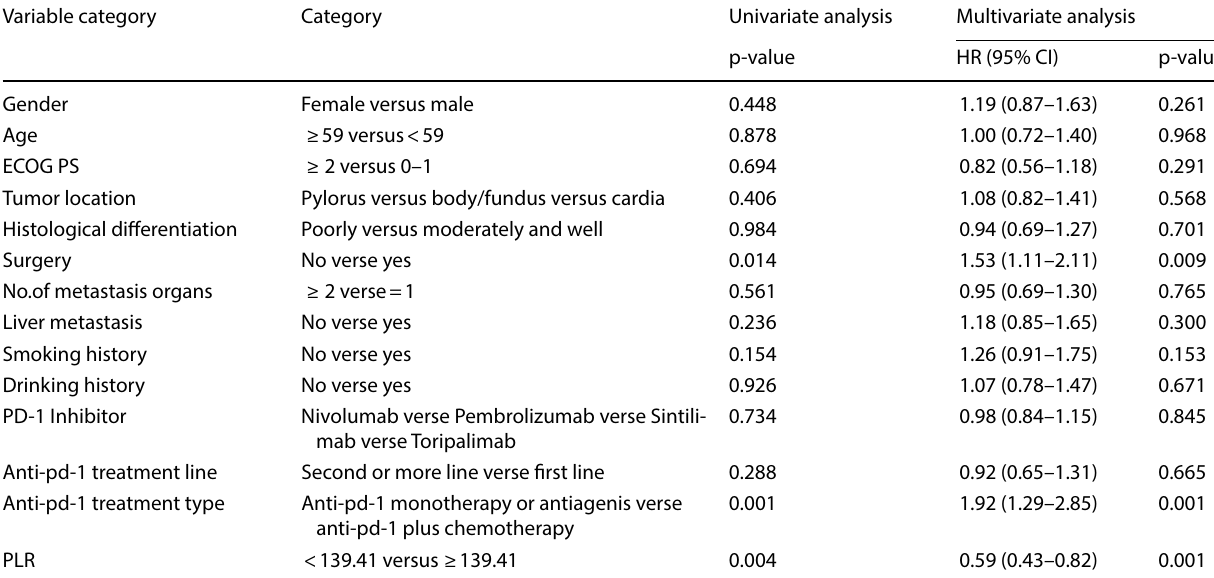
Table 3 Univariate analysis and multivariate analysis of overall survival time (OS)